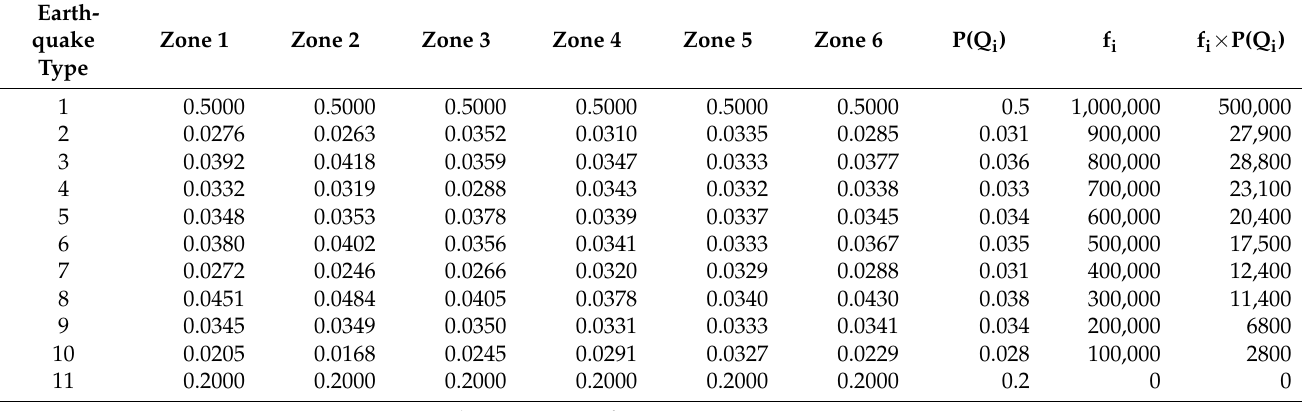
Table 29. The calculated result of probability type-i and expectation of face amount for clustering type II.